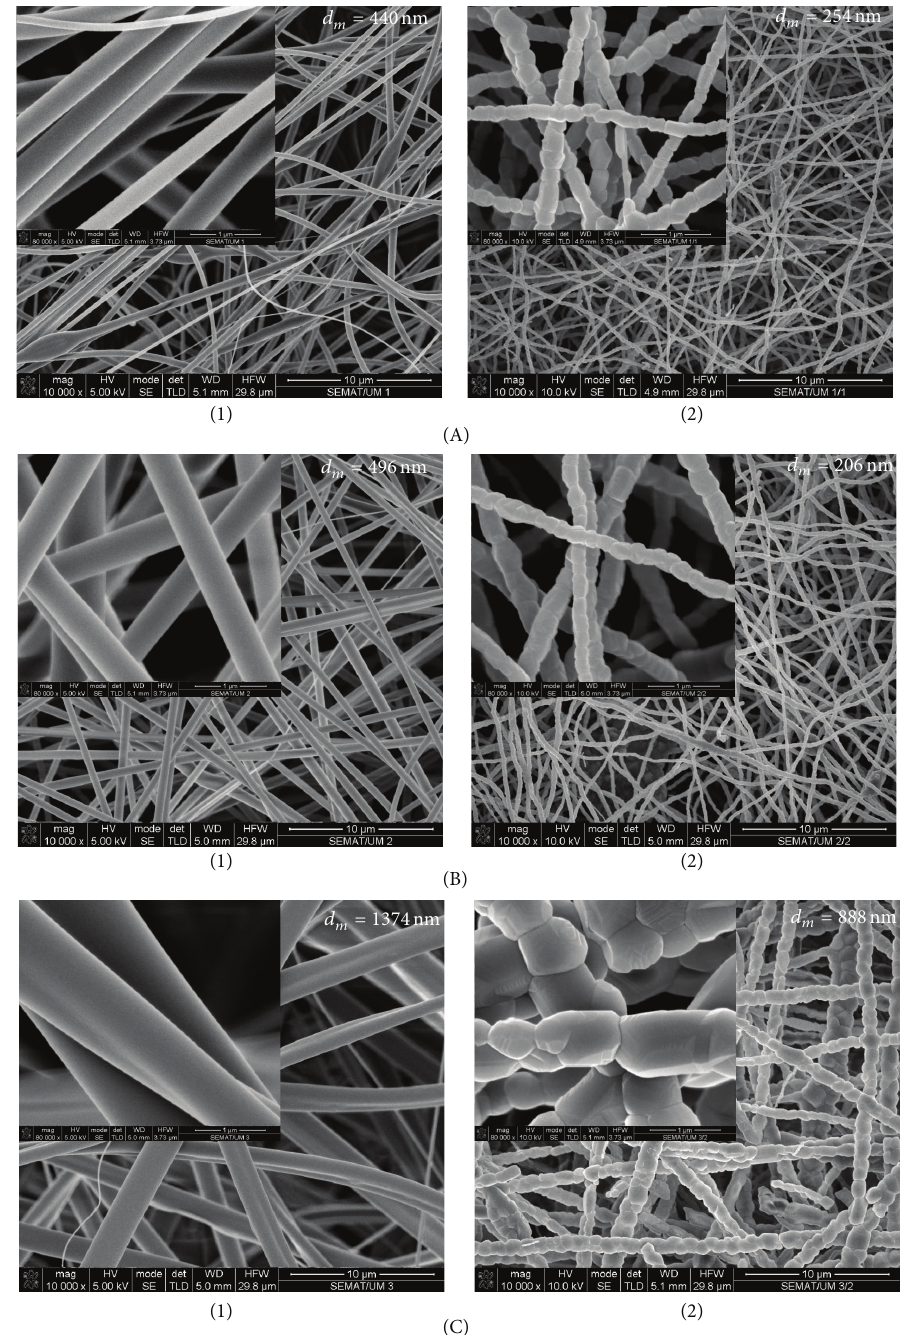
Figure 1: SEM analysis of solutions (A), (B), and (C) before (1) and after calcining (2). Also are the peak positions (vertical lines) corresponding to the anatase (ICDD 00-021-1272) and rutile (ICDD 00-021- 1276) phases expected for TiO 2